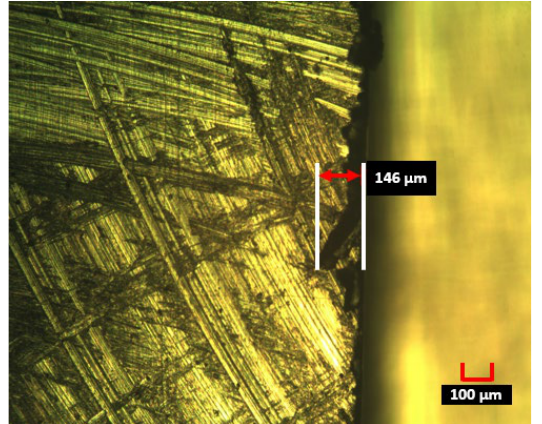
Figure 6 . Minimum burr width noted on up-milling side of the workpiece.